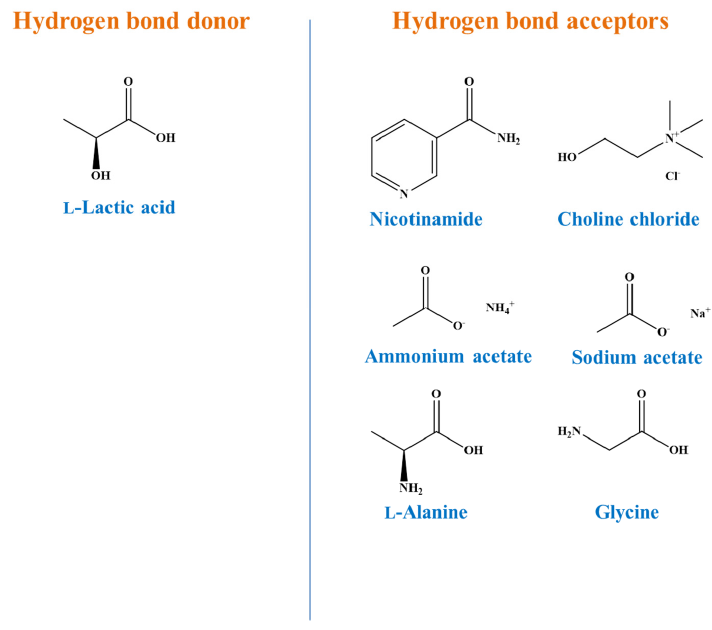
Figure 1. Formulae of L ‐ lactic acid (HBD) and the HBAs used in this study. Table 1. Codes and names of the medicinal plant specimens used in this study.